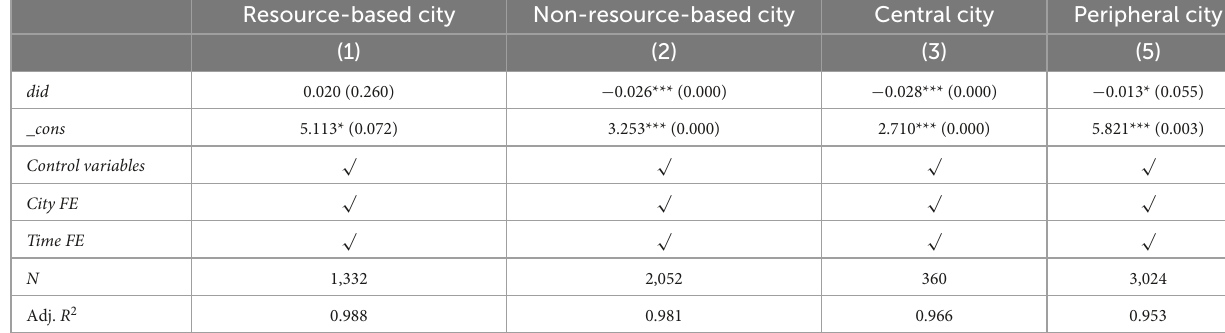
TABLE 6 Heterogeneity analysis of city types and